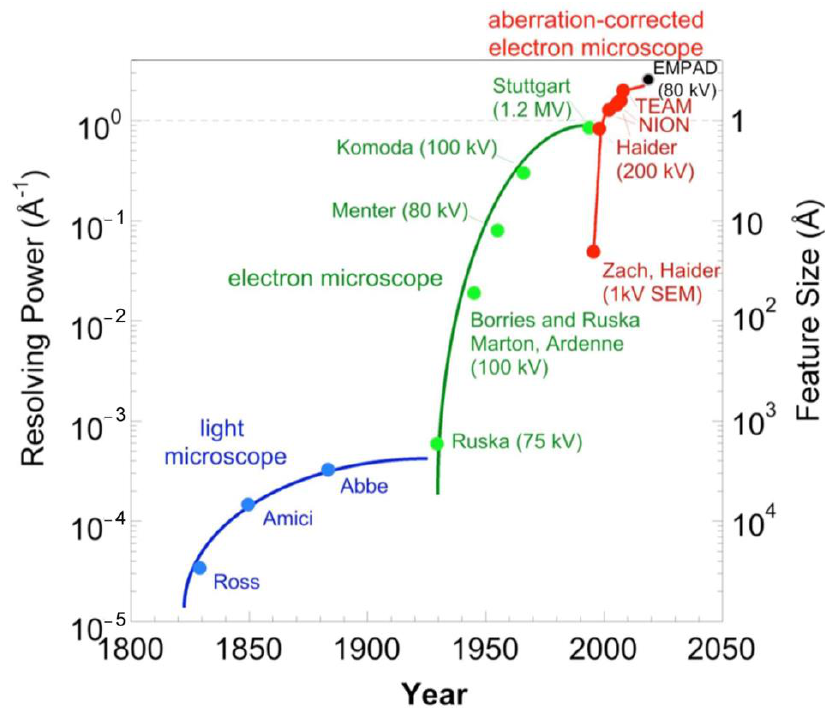
Figure 1. Historical evolution of the electron microscope resolving power (reproduced from: “ Smaller than the space between atoms: The technology behind the highest-resolution microscope image ”, courtesy of Muller, D.A.).